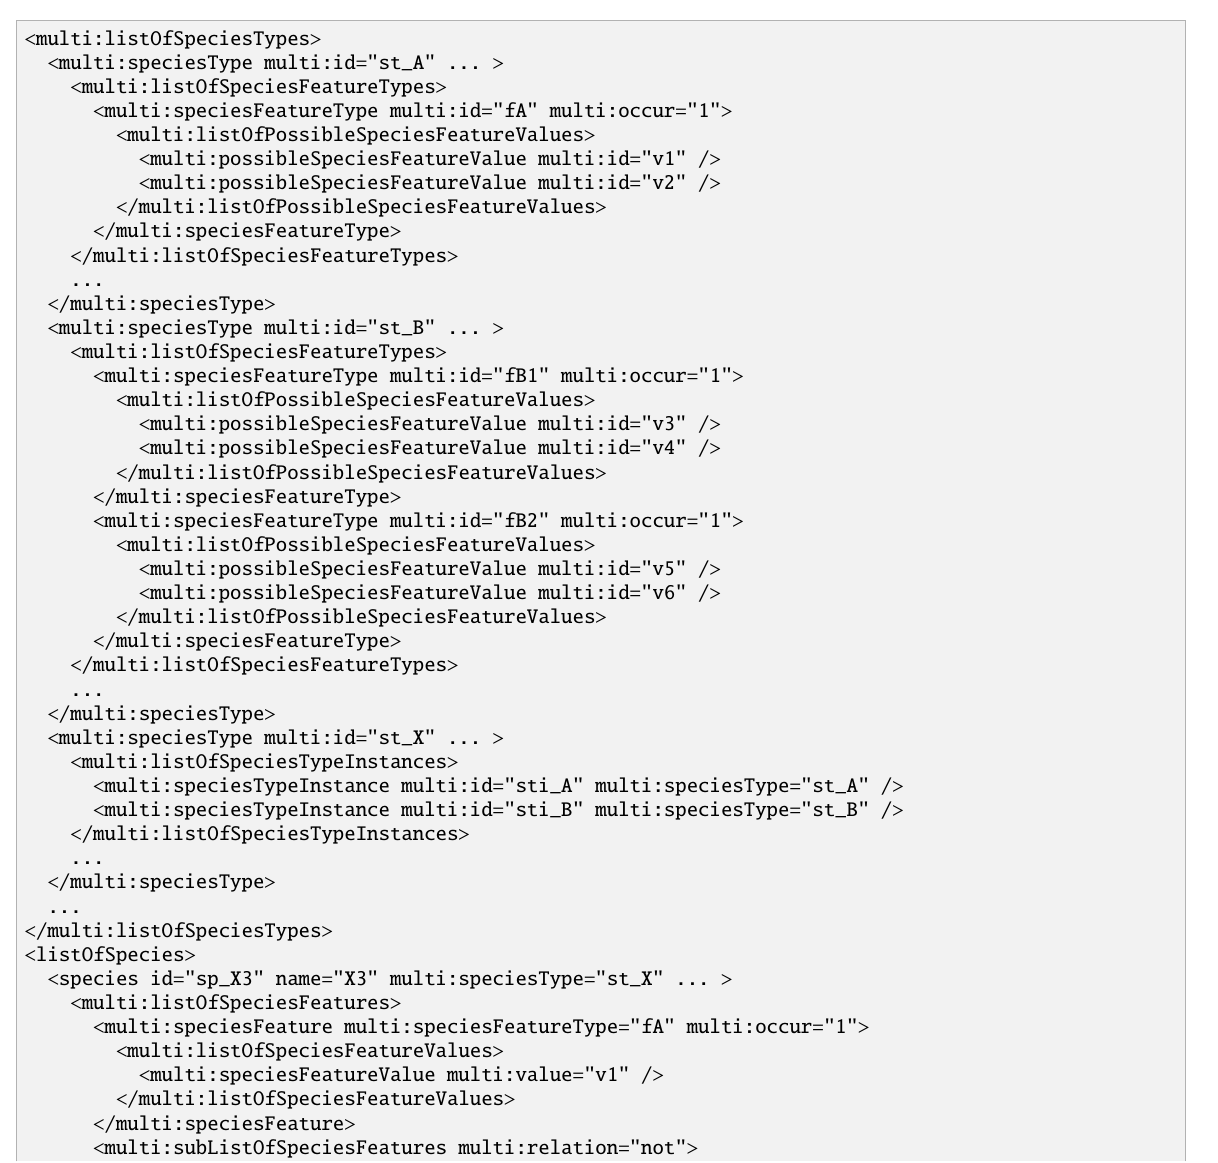
The SBML code for the speciesType s “ st_A ”, “ st_B ”, and “ st_X ”, and the species “ sp_X3 ” can be as